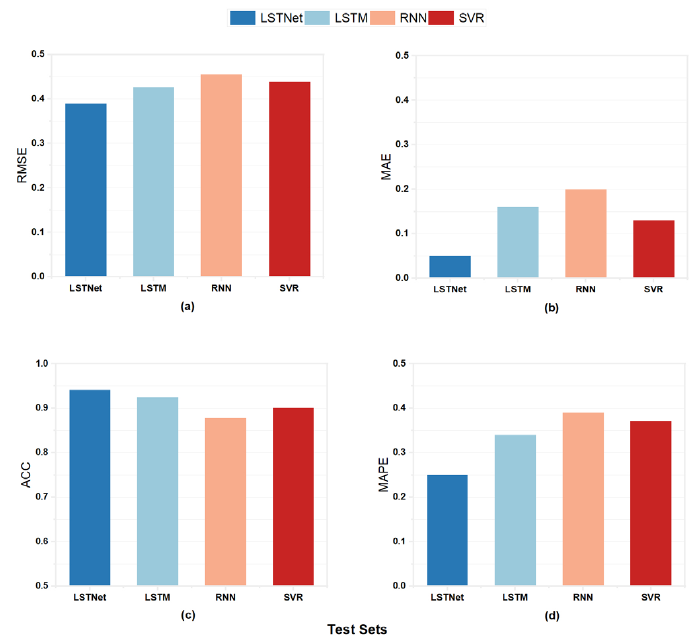
Figure 10. Model comparison.